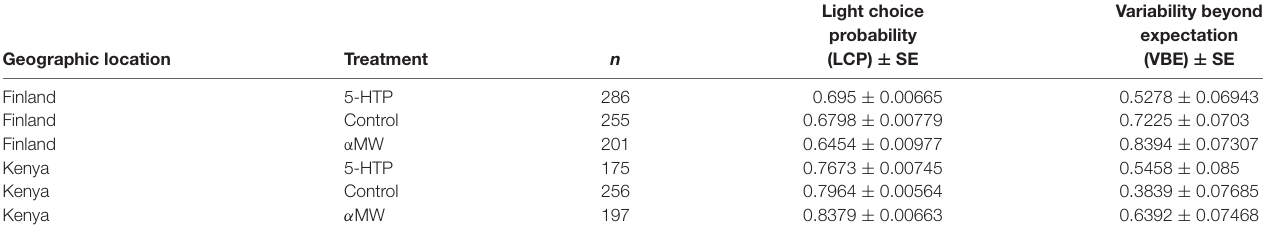
TABLE 1 | Descriptive statistics of light-choice probability (LCP) and variability beyond expectation (VBE); ± SE were based on bootstrap resampling (5,000